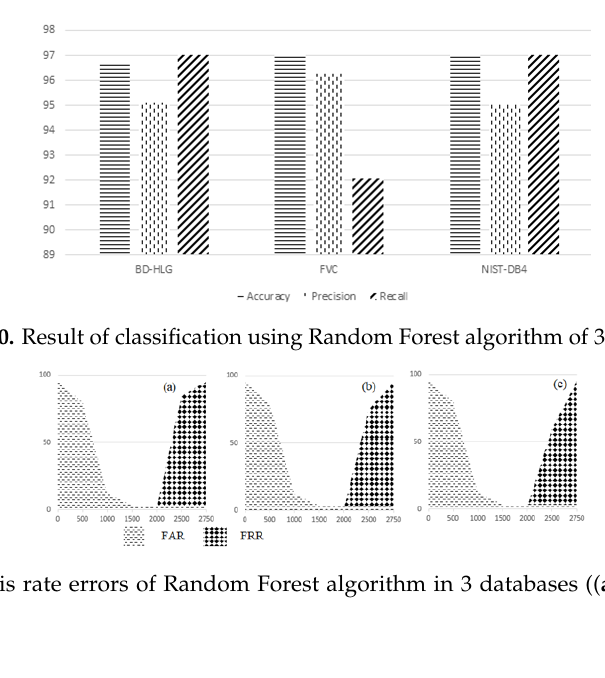
Figure 9. Analysis rate errors of Support Vector Machine algorithm in 3 databases (( a ) BG-HLG, ( b ) FVC, ( c ) NIST-BD4).